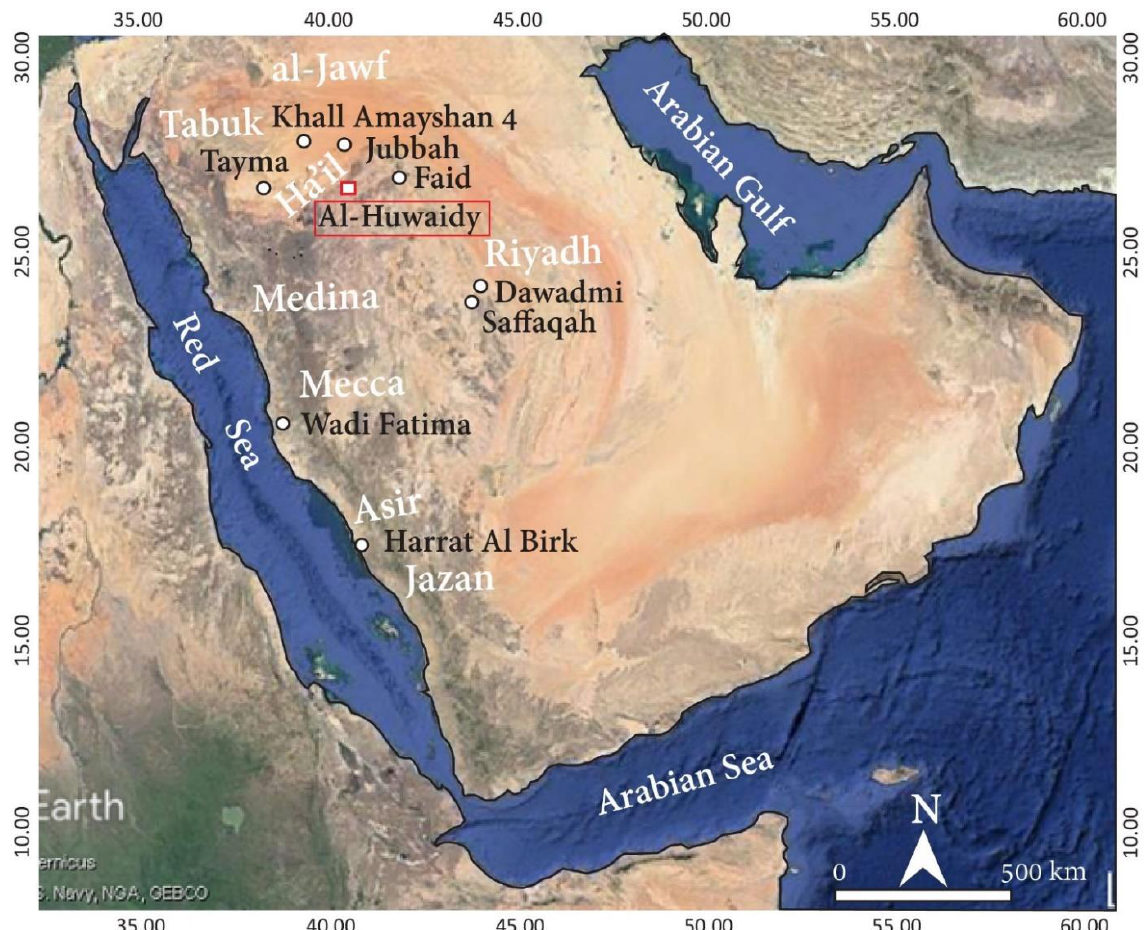
Figure 1: Location of Al-Huwaidy Palaeolithic site in northwest of Saudi Arabia and the main Palaeolithic localities and regions referred to in the text (names in black are Palaeolithic localities and names in white are